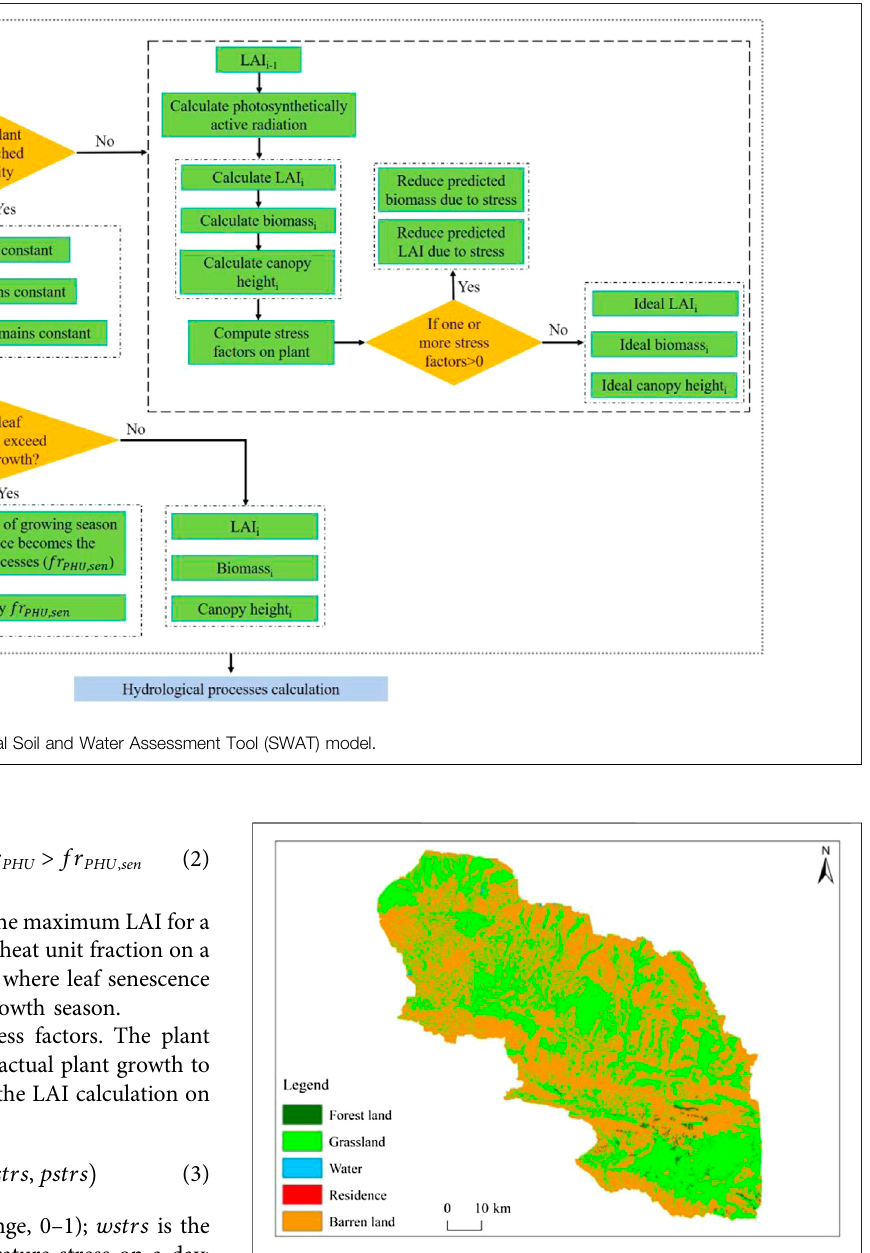
FIGURE 2 | Land use/cover type in the study